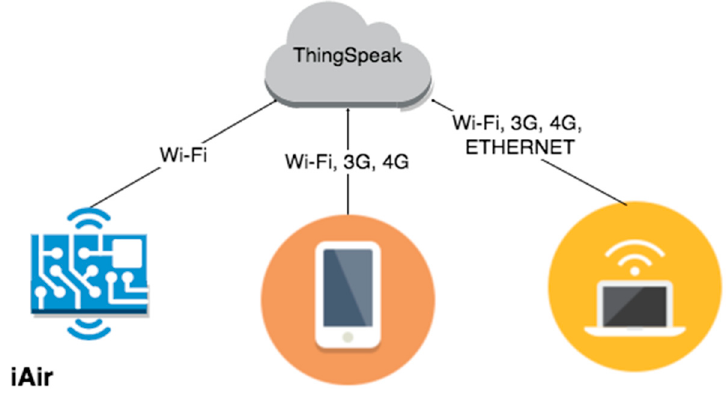
F igure 1. iAir system architecture. Figure 1. iAir system